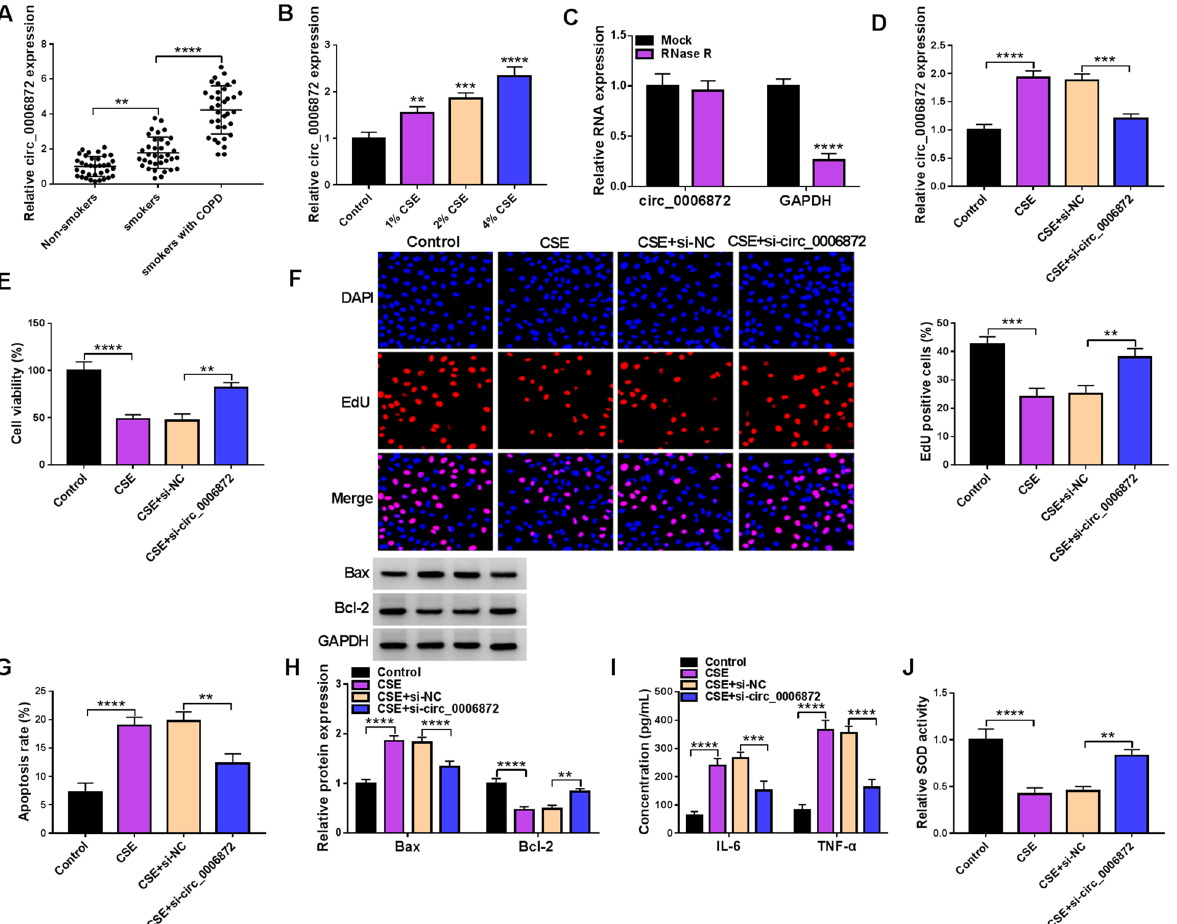
Fig. 2 Knockdown of circ_0006872 attenuates CSE-induced 16HBEC injury. A The expression level of circ_0006872 was detected using qRT-PCR in non-smokers (n 35), smokers (n 35), and smokers with COPD (n 35). B Levels of circ_0006872 in 16HBECs exposed to different concentrations = = = of CSE. C Stability analysis by RNase R treatment. D – J 16HBECs were transfected with si-circ_0006872 or si-NC and then exposed with 2% CSE